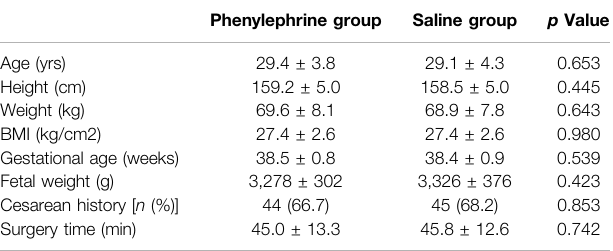
TABLE 1 | Demographic data and surgical times.